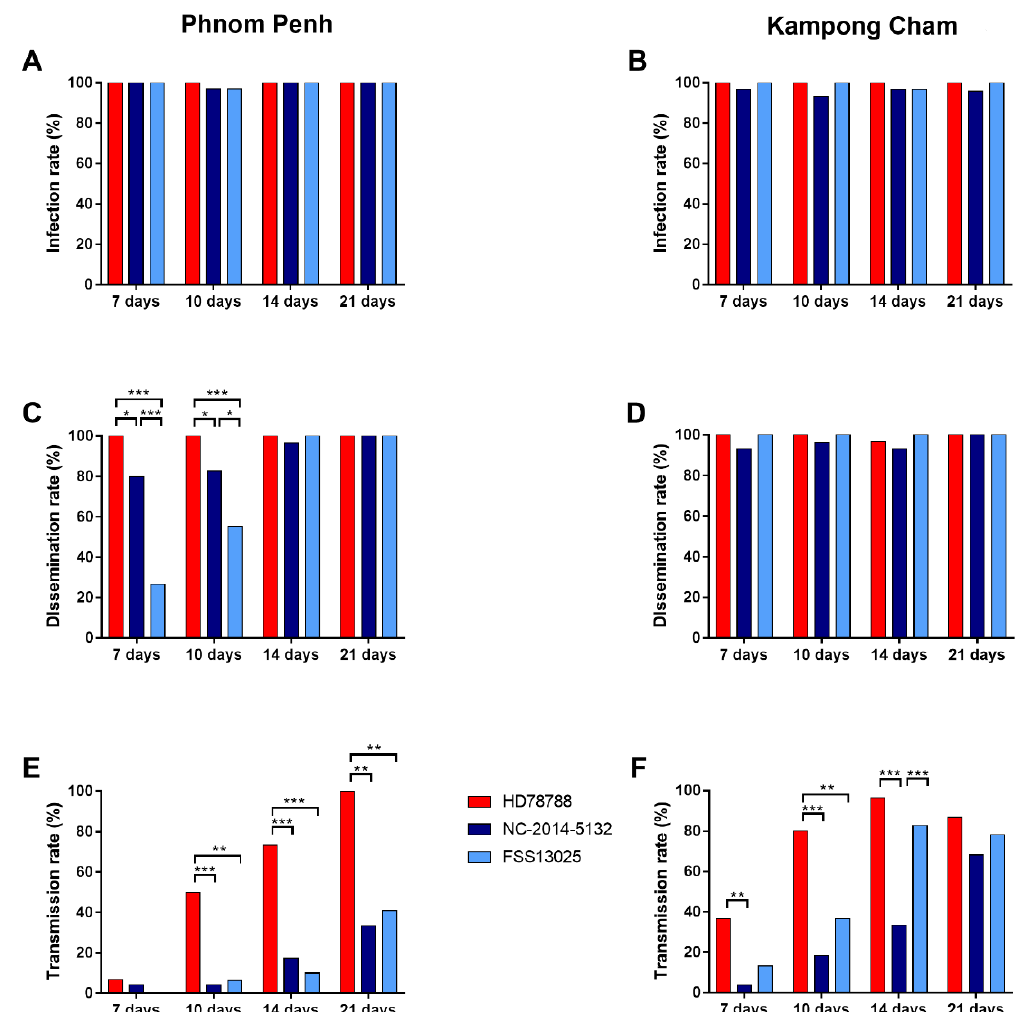
Figure 2. Infection, dissemination, and transmission rates of Cambodian Ae. aegypti mosquitoes. Ae. aegypti populations from Phnom Penh ( A , C , E ) and Kampong Cham ( B , D , F ) were infected with ZIKV HD78788 (red), NC-2014-5132 (dark blue), or FSS13025 (light blue). Infection rates ( A , B ) are expressed as the percentage of mosquitoes with ZIKV-positive bodies among the total number of blood-fed mosquitoes. Dissemination rates ( C , D ) are expressed as the percentage of mosquitoes with ZIKV-positive head, legs, and wings among the mosquitoes with ZIKV-positive bodies. Transmission rates ( E , F ) are expressed as percentage of mosquitoes with ZIKV-positive saliva among mosquitoes with ZIKV-positive bodies. Statistical differences determined with Fisher’s exact test are marked by asterisks: * p < 0.05, ** p < 0.01, and *** p < 0.001.